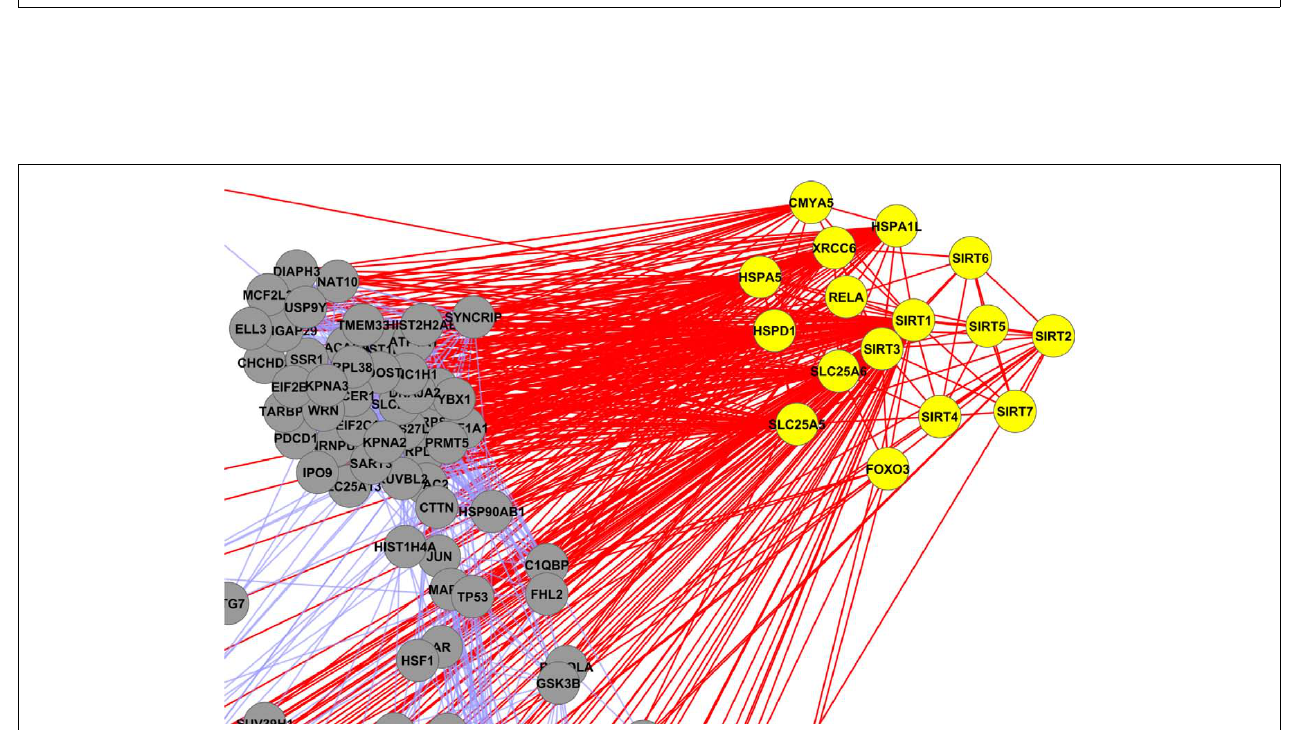
FIGUREA7 | Different view of active site (represented in the surface conformation by Pymol) of four directions. Concerning a clockwise direction, the first view shows the front view (A) , the second shows the top view (B) , the third shows the side view (C) , and the fourth shows the rear side view of active site residues (D) .